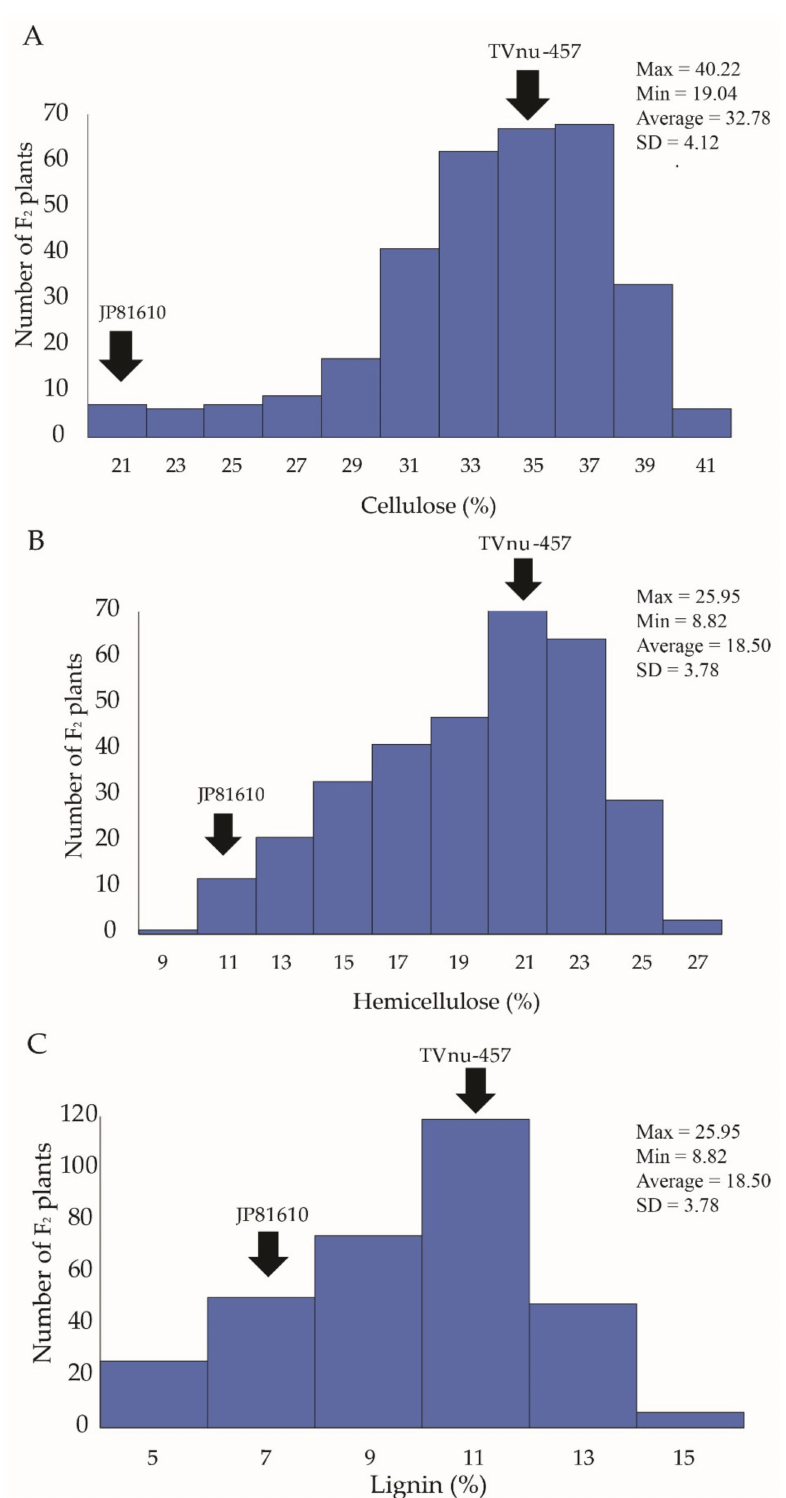
Figure 1. Frequency distribution of cellulose ( A ), hemicellulose ( B ) and lignin ( C ) content of dry pod in F 2 population F2B of the cross JP81610 × TVnu-457. The fibers were determined by the fiber bag technology